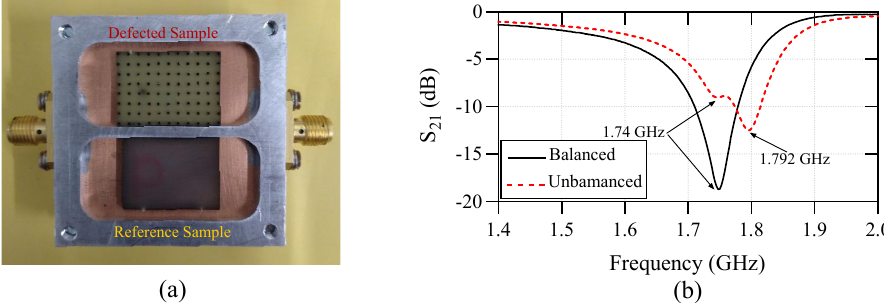
Figure 9. ( a ) The sensor setup as a comparator using a perfect and a defected FR4 dielectric slabs. ( b ) The measured responses of the sensor with balanced and unbalanced loadings of FR4